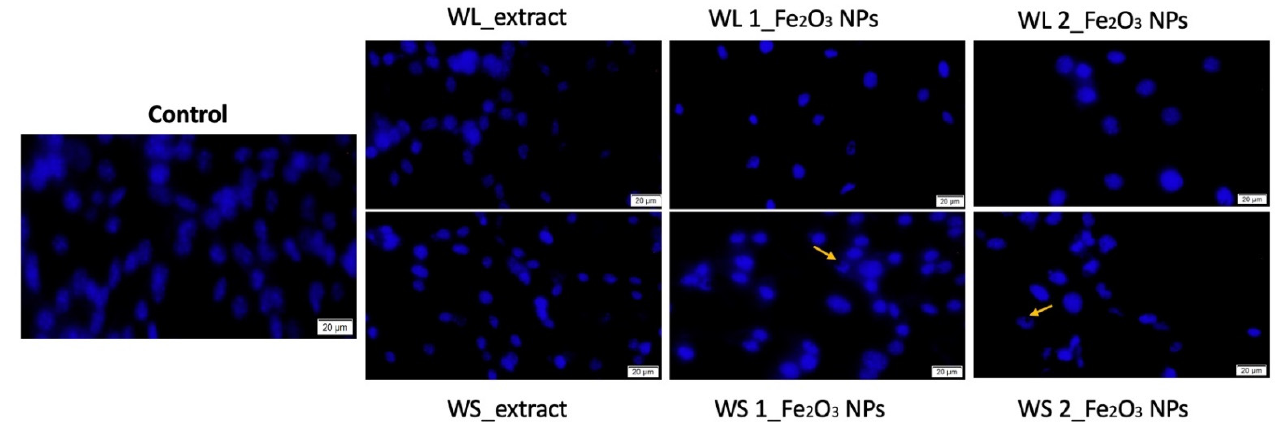
Figure 14. Morphological aspects of immortalized human keratinocytes-HaCaT nuclei treated with concentration of 500 µg/mL of both wormwood extracts: leaves (WL_extract) and stems (WS_ex- tract) and different Fe 2 O 3 NPs obtained from these extracts (WL 1_Fe 2 O 3 NPs; WL 2_Fe 2 O 3 NPs, respectively WS 1_Fe 2 O 3 NPs; WS 2_Fe 2 O 3 NPs) for an interval of 72 h. The scale bars represent 20 µm. Fe 2 O 3 NPs that are either attached or embedded in the cells nuclei are marked with yellow arrows.